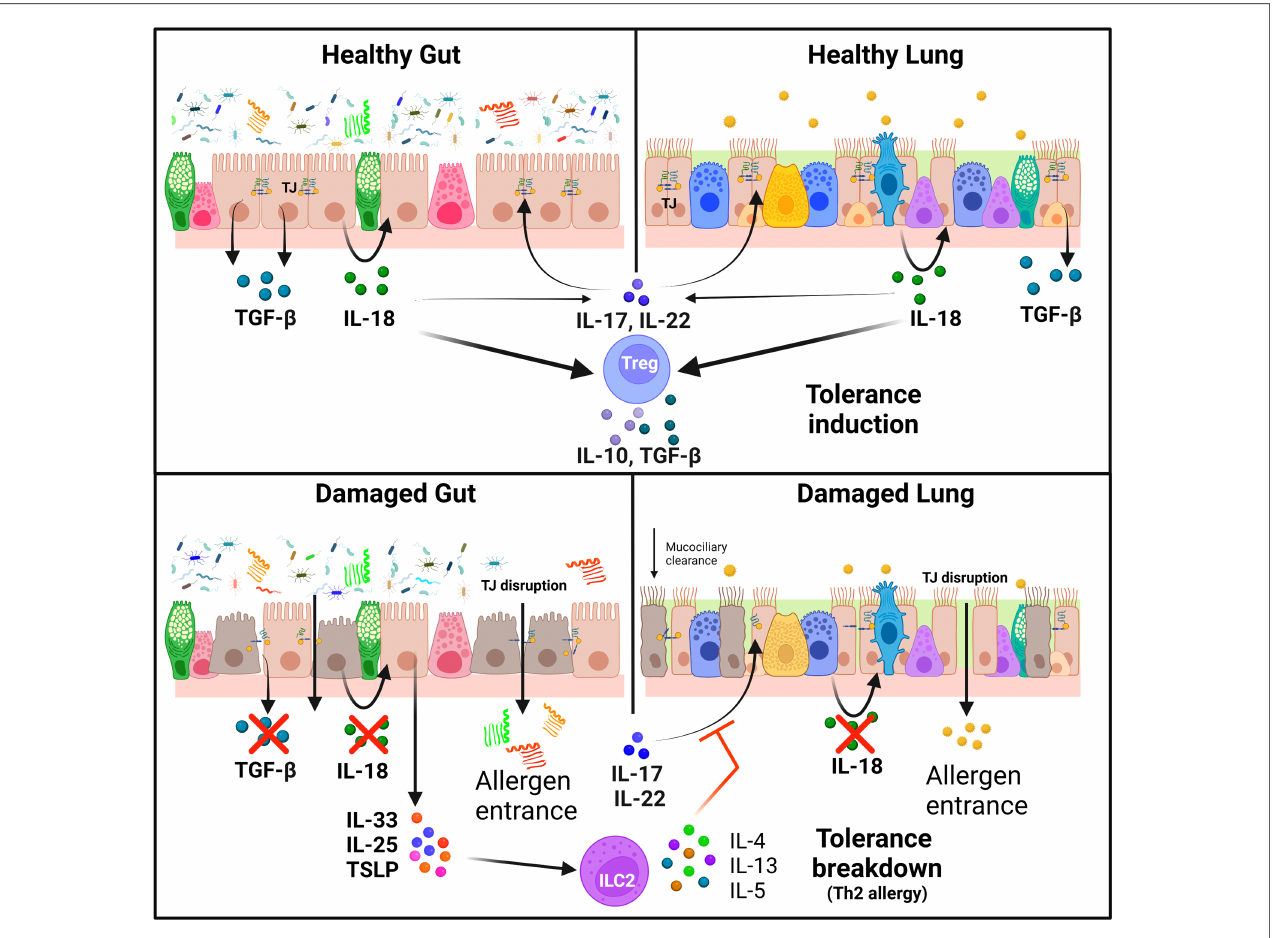
FIGURE 1 Immunoregulation of tolerance induction and breakdown in healthy and damaged epithelia. Tight junctions are essential for the maintenance of healthy gut and lung epithelial barriers. IL-17 and IL-22 induce the expression of TJ proteins, but this effect is impaired in the presence of Th2 cytokines. Healthy epithelial cells release IL-18 and TGF- β in response to allergens, which enhance the production of IL-17 and IL-22 and stimulate T reg cells to release IL-10 and TGF- β , leading to tolerance induction. On the other hand, epithelial cells in damaged barriers secrete alarmins (IL-25, IL-33 and TSLP) which trigger tolerance breakdown with the activation of a Th2 response in ILC2 cells with the release of IL4, IL-5 and IL-13 (Created with